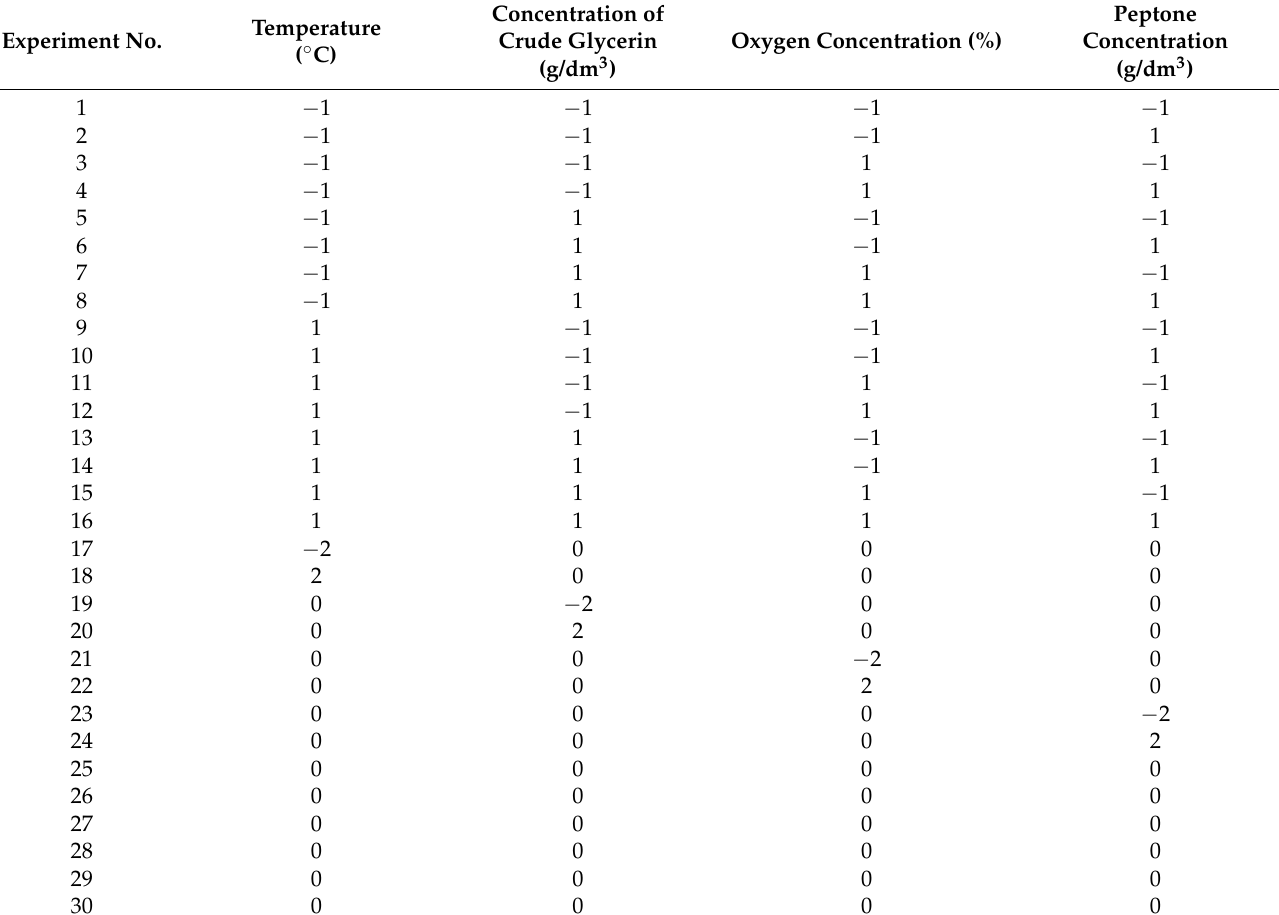
Table 6. Experimental matrix designed using response surface methodology, with coded levels of significant parameters.